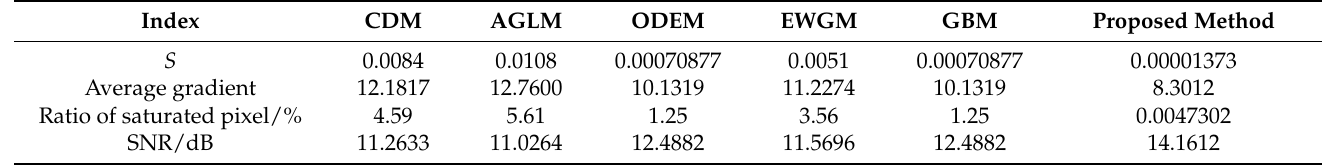
Table 3. Comparison of quantitative indices of the optimal exposure image of each method under dark